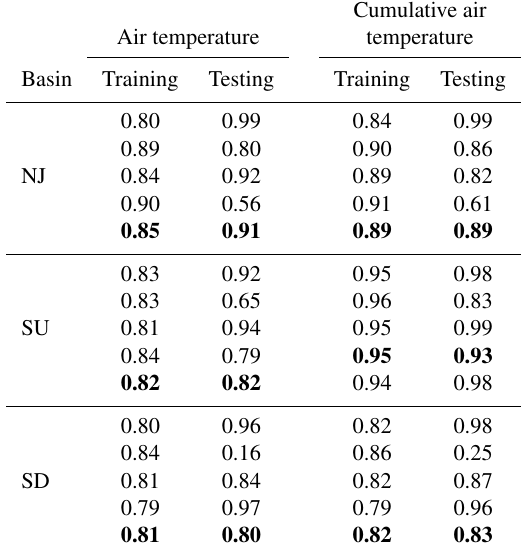
Table 4. The cross-validation of Bayesian linear regression using the k fold method, and the K value was set as 5. Ice thickness was treated as dependent variables, and air temperature and snow depth on ice were treated as independent variables. Air temperature and cumulative air temperature of freezing were considered in the model building. The R 2 values of the best linear regression avoiding over- fitting are marked in